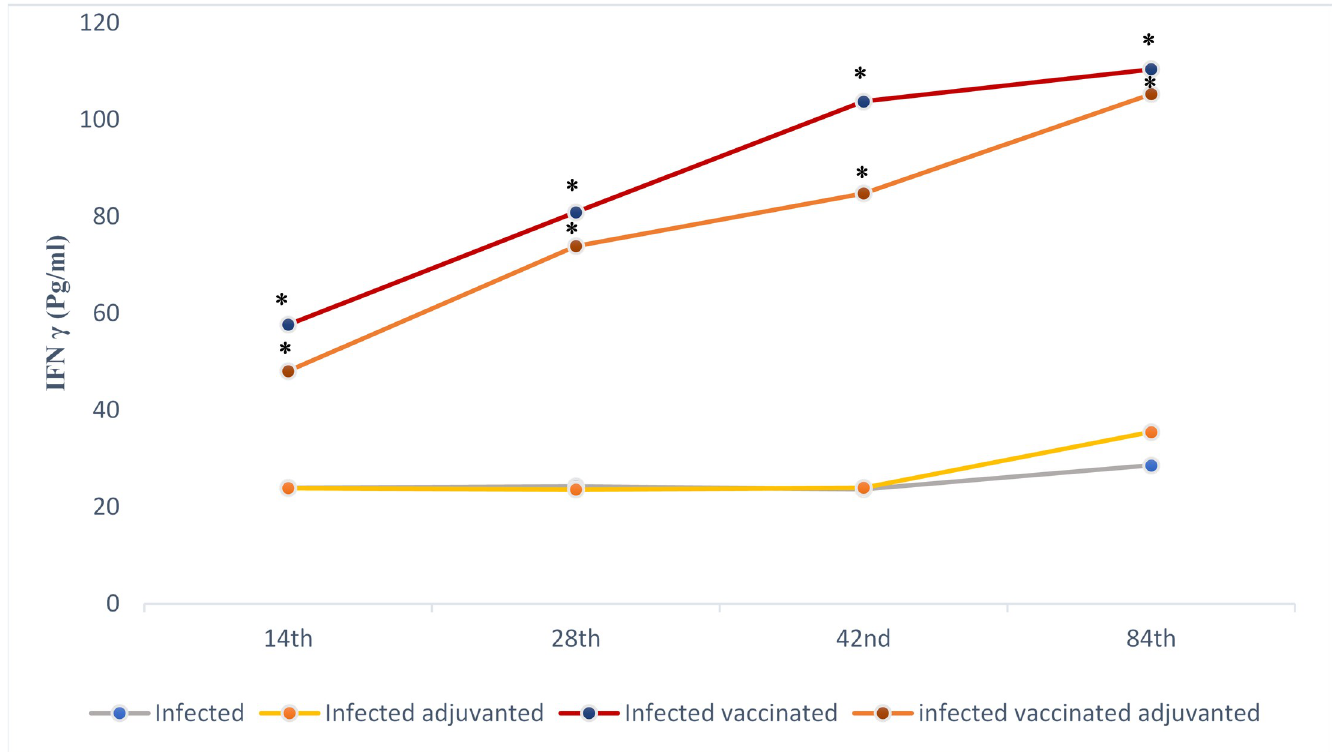
Fig 8. IFN γ levels in mice of different studied groups. Sera of mice were collected at days 14, 28, 42, and 84 after the first immunization and assayed by ELISA. ( � ) Statistically significant at p � 0.05.